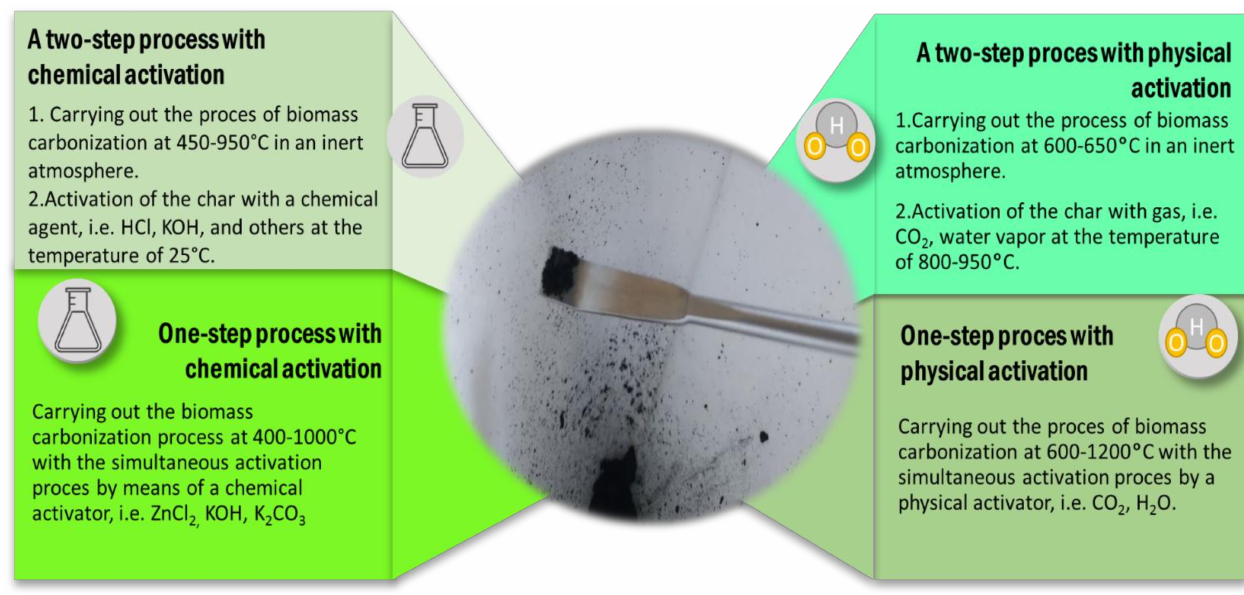
Figure 5. The most popular methods of obtaining porous bioadsorbents used in carbon dioxide capture.